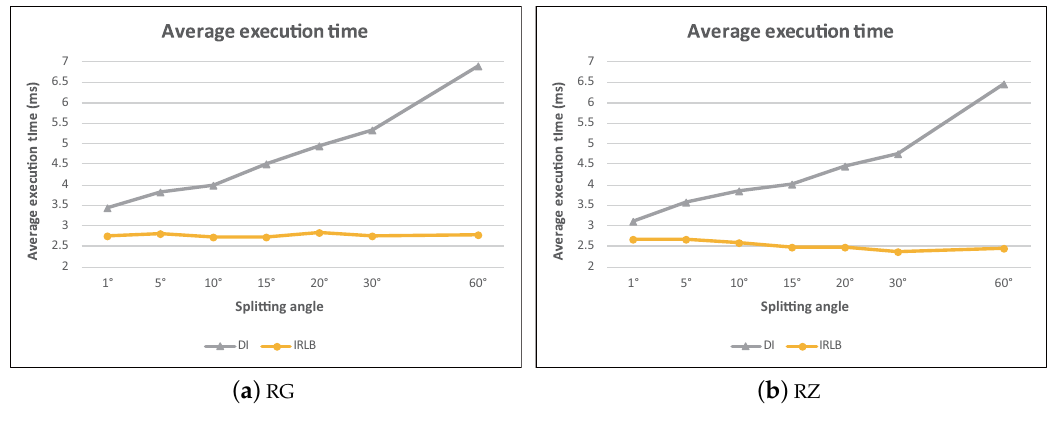
Figure 29. Average execution time vs. θ S .